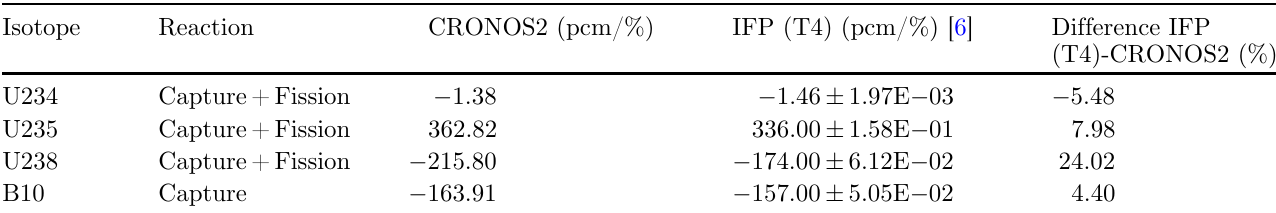
Table 2. CRONOS2 sensitivities compared to IFP sensitivities coming from TRIPOLI4 code [6]. Isotope Reaction CRONOS2 (pcm/%)